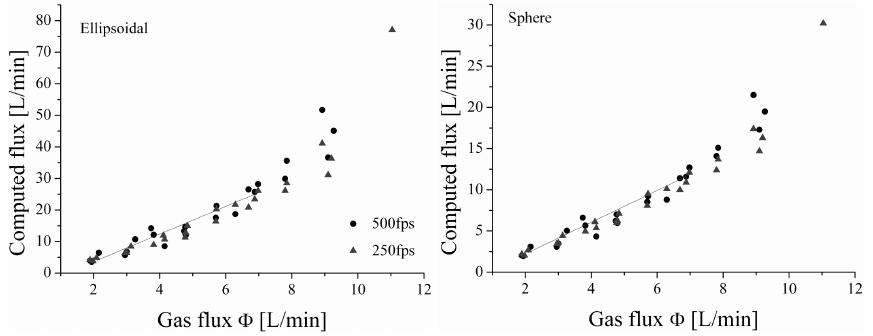
Fig. 5. In both models the computed flux can be linearly correlated to the physical flux. The ellipsoidal model yields an overestimation factor of 4.8 ± 0.6 while the sphere model yields an overestimation of 2.2 ± 0.3.